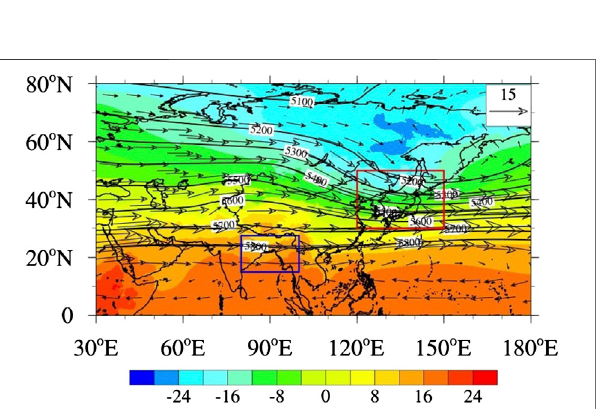
FIGURE 5 | Spatial distributions of climatological DJF mean 500 hPa geopotential height (contour, unit: m), horizontal wind (vectors; m/s) and 850 hPa air temperature (shaded; unit: ° C). Blue rectangular means Southern Branch Trough area, red rectangular means the East Asian Trough area.